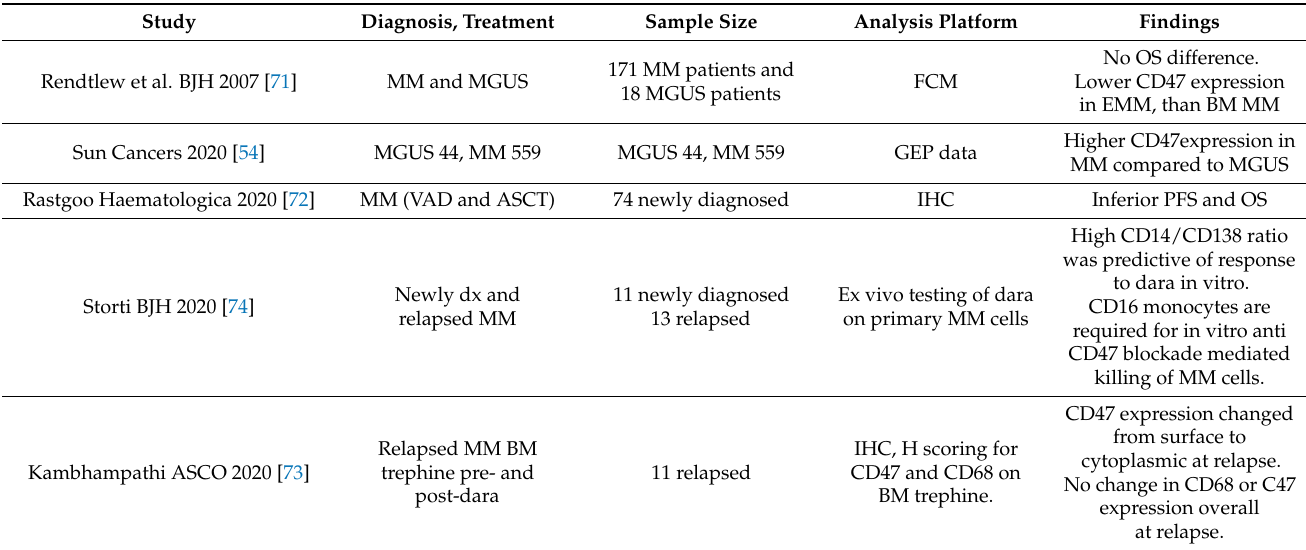
Table 3. Studies evaluating the CD47:SIRP alpha axis in multiple myeloma (MM). MGUS = mono- clonal gammopathy of undetermined significance. VAD = vincristine, doxorubicin, dexamethasone; ASCT = autologous stem cell transplant; Dara = daratumumab; PFS = progression-free survival; OS = overall survival; IHC = immunohistochemistry; FCM = flow cytometry; BM = bone